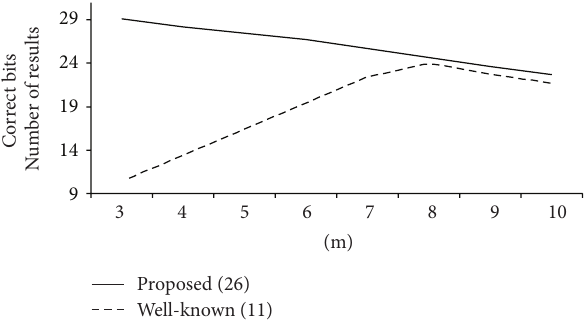
Figure 7: Number of correct bits of result as a function of 𝑚 at 𝑅 = 2 2𝑚+3 and 𝑑 = 32 . Table 6: Maximum values of the absolute radial error ( 𝑅 = 2 2𝑚+3 ) for Algorithm